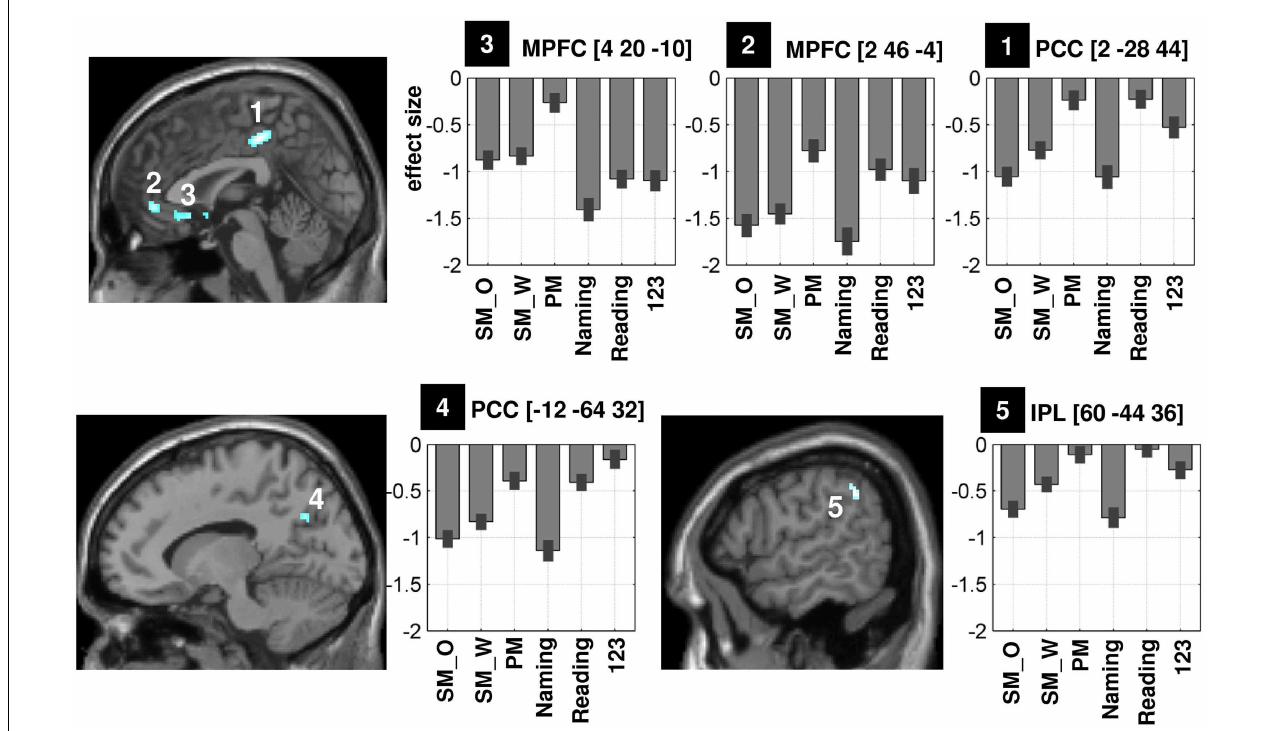
were not significant, the effect sizes (in the bar graphs) for the unfamiliar stimuli were averaged to simplify the illustration. Coordinates are shown on top of each bar graph. PCC, precuneus and posterior cingulate cortex; MPFC, medial prefrontal cortex; RIPL, right inferior parietal lobule; SM_O, semantic matching on objects; SM_W, semantic matching on words; PM, perceptual matching on unfamiliar stimuli; 123, say “1,2,3” to unfamiliar